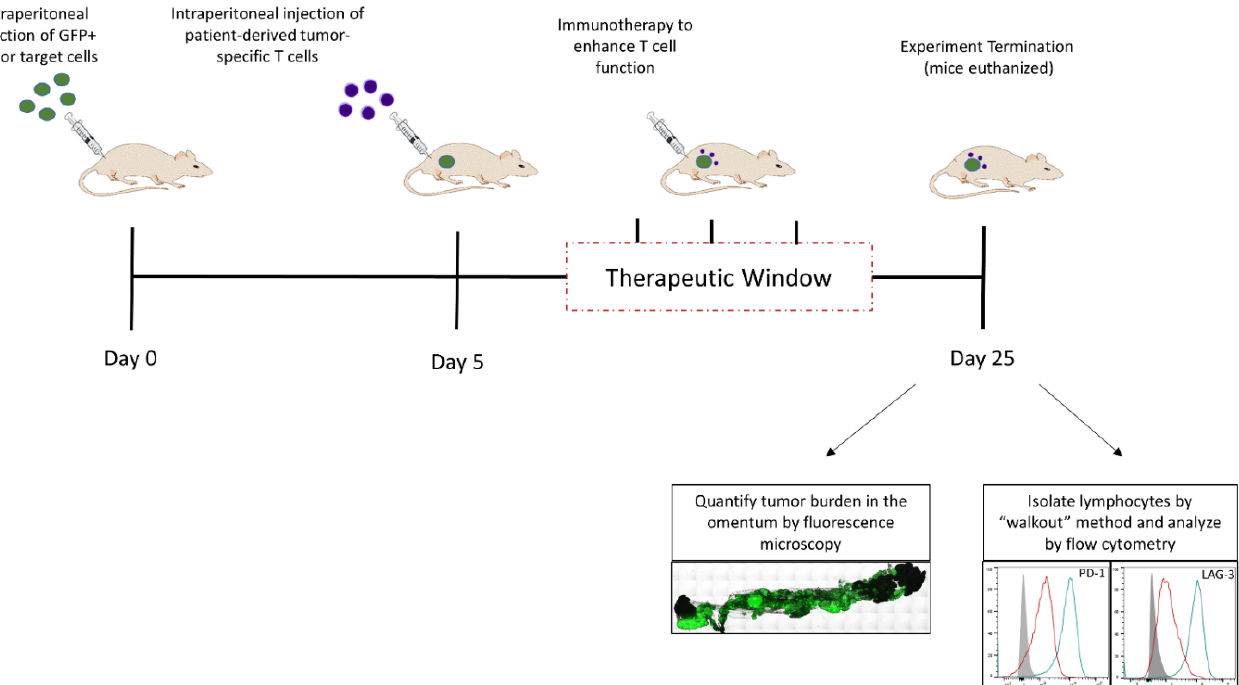
Figure 3. The Xenomimetic Mouse (X-mouse) Model. Xenografts are established in the greater omentum of NSG mice by intraperitoneal injections of GFP+ tumor targets on day 0 and patient-derived neoantigen-specific cells on day 5. Immunotherapeutics designed to enhance T cell function are administered in the “therapeutic window” between day 10 and day 25. On day 25, the mice are euthanized and omenta removed to allow quantification of tumor burden. Lymphocytes are isolated using the “walkout” method and phenotyped by flow cytometry. Representative data shown are original unpublished data generated by the authors.